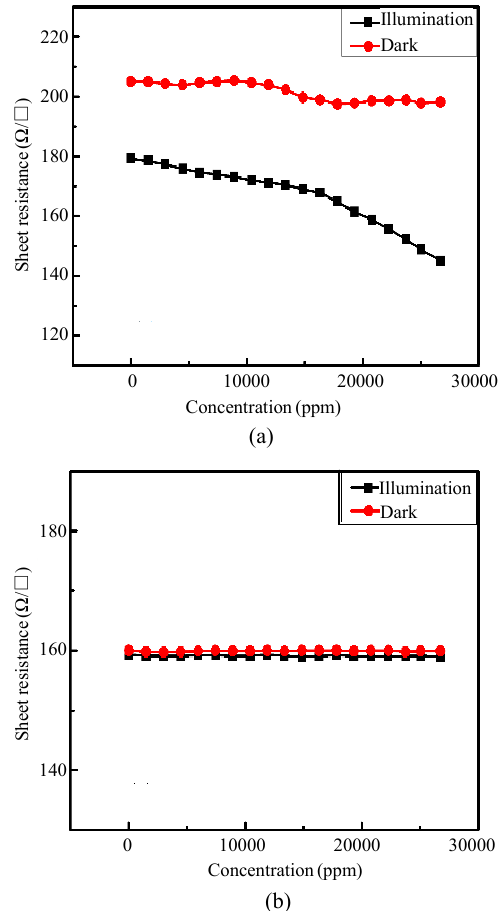
Fig. 6 Sheet resistance as a function of the acetone concentration: (a) the coupling sample and (b) the reference